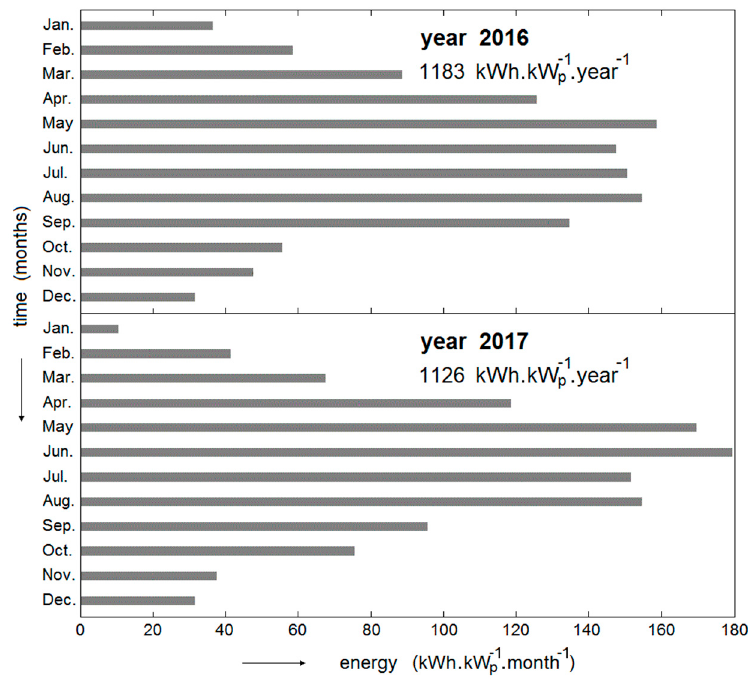
Figure 4. Electric energy production during 2016–2017.